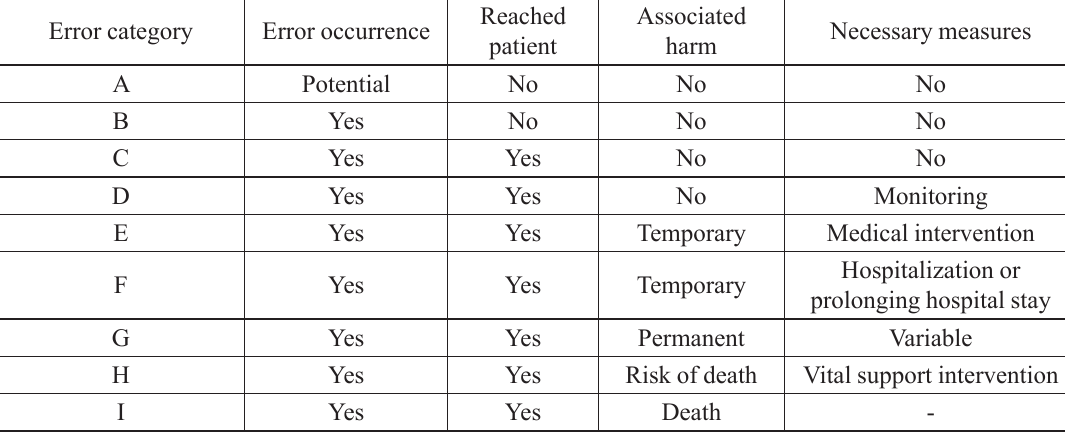
FIGURE 1 - Classification of seriousness of medication errors according to the National Coordinating Council for Medication Error Reporting and Prevention